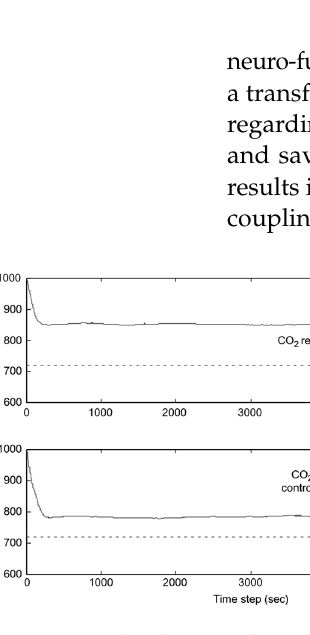
Figure 5. Example showing the comparison between CO 2 concentration ( left ) and illuminance ( right ) level in a fuzzy controller before and after GA optimisation [30].